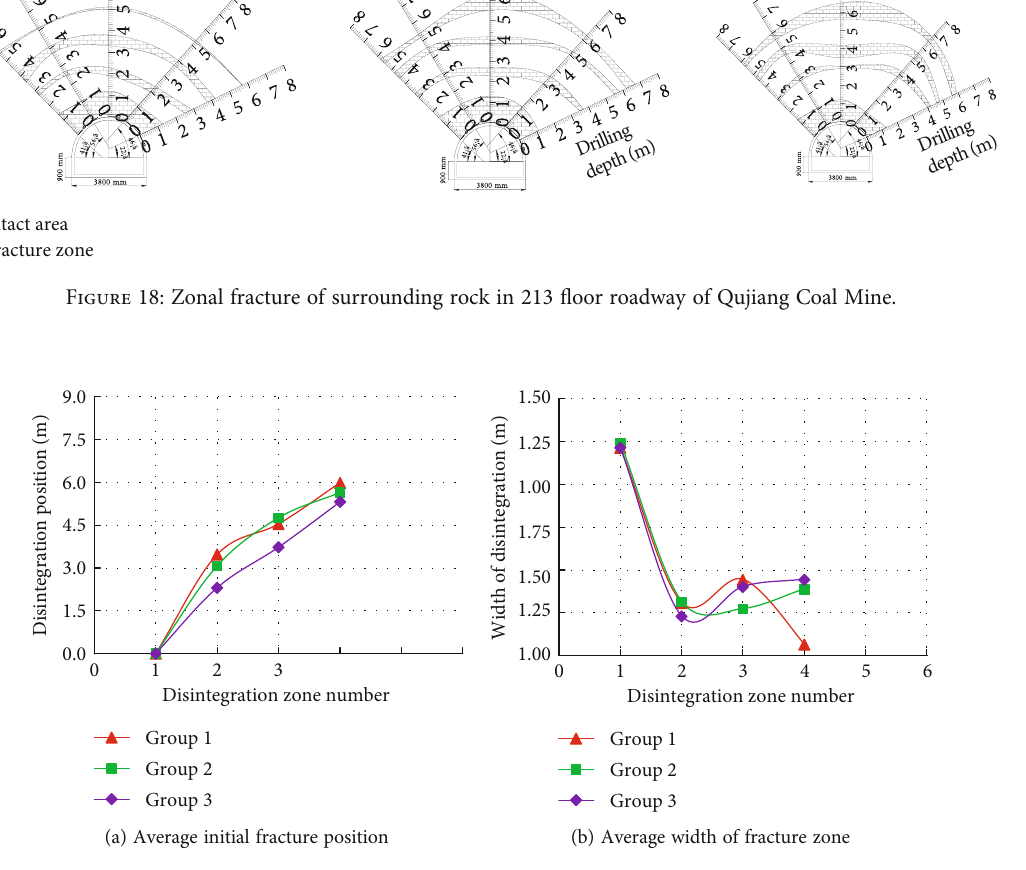
Figure 17. The fracture zones above 0.2 m of di ff erent drill